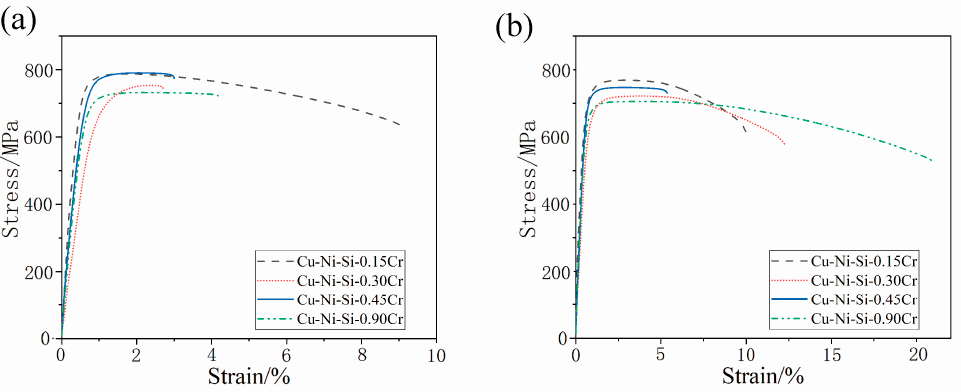
Figure 8. Stress strain curves of CuNiSiCr alloys subjected to the two-step aging treatment: ( a ) CR 50% +